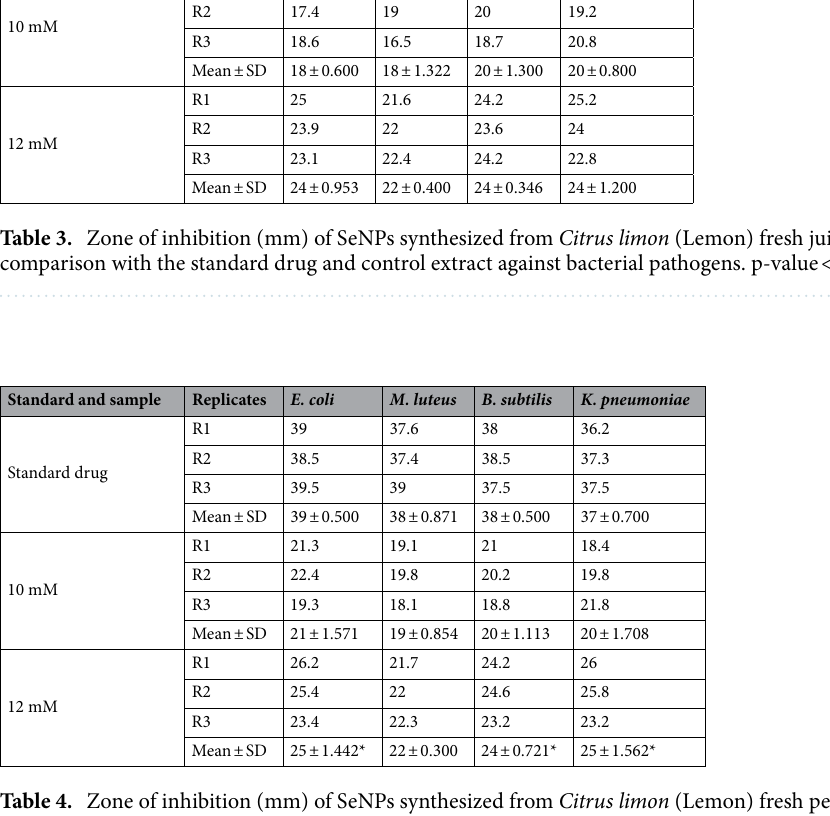
Table 4. Zone of inhibition (mm) of SeNPs synthesized from Citrus limon (Lemon) fresh peels extract in comparison with the standard drug and control extract against bacterial pathogens. *p-value < 0.05.